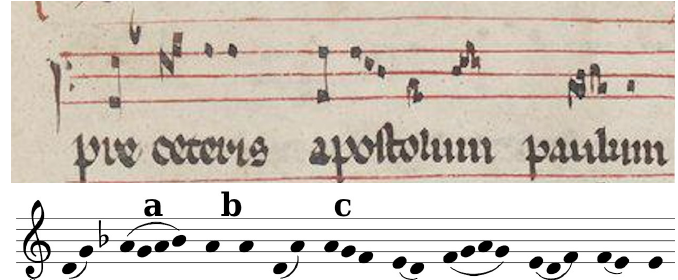
Figure 1. An example transcription equivalent in modern notation (bottom image) based on a neume notation (upper image). A neume consisting of graphical connected note components (NCs) (a) is visualised by a slur, each new neume starts with an increased space (b), logical connected NCs are notated with small note space (c). The modern notation maintains the relevant information for performing the historical neume notation. The example image is taken from our corpus introduced in Section